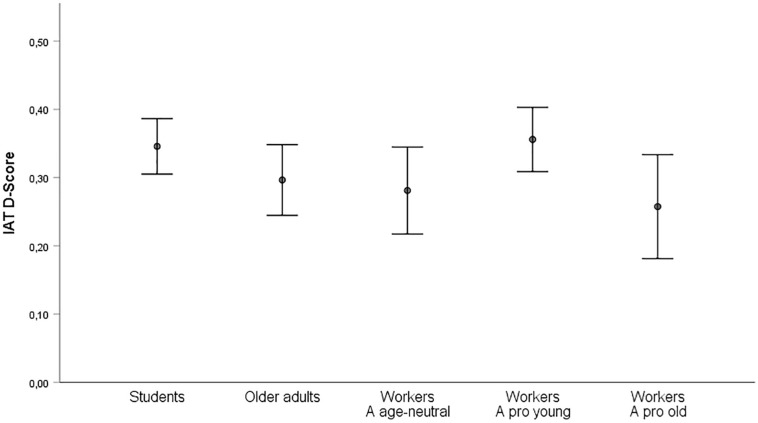
Mean D scores and standard errors for groups (students, older adults, workers) and experimental conditions for workers (age-neutral attribute stimuli, young-associated attribute stimuli, old-associated attribute stimuli).